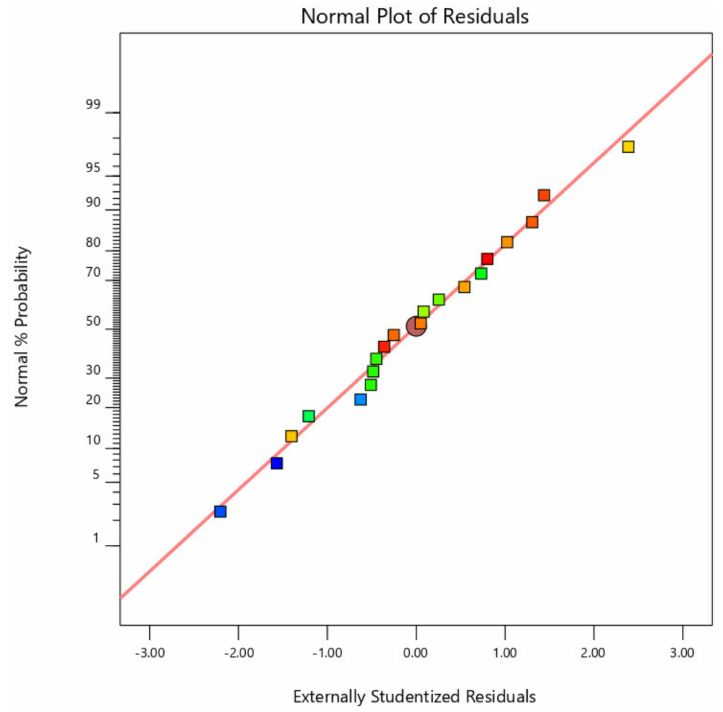
Figure 3. Normal plot of residuals for coating width (C w ).